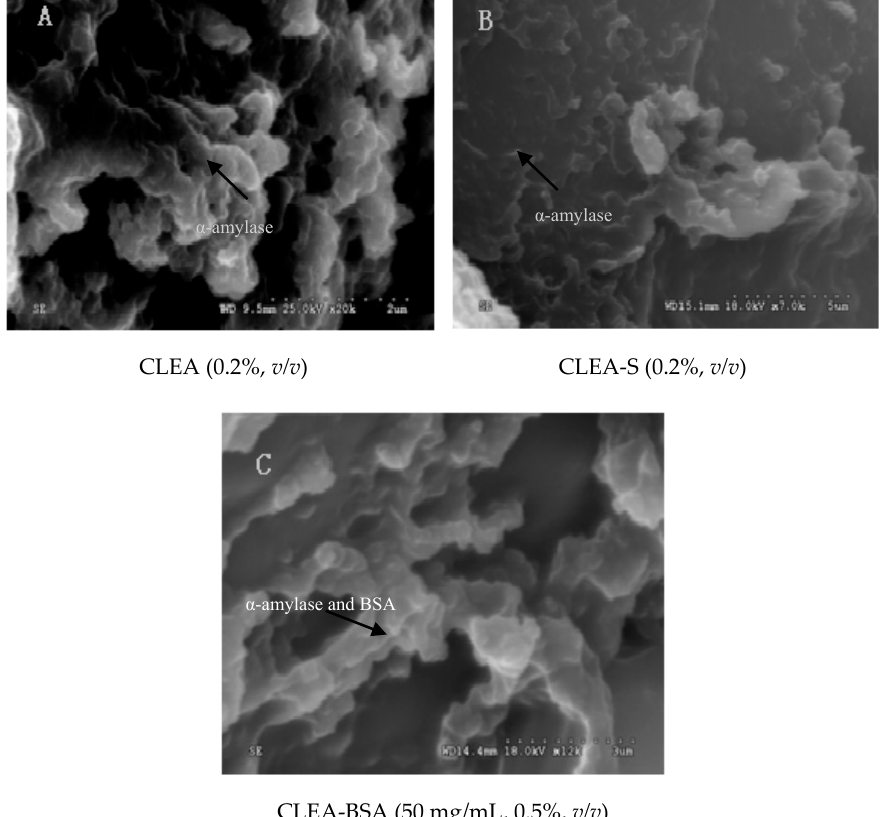
Figure 6. Scanning electron micrographs of ( A ) α -amylase CLEA absence of starch with 0.2% ( v / v ) glutaraldehyde concentration and magnified 20,000 × ; ( B ) CLEA with 2% starch solution and 0.2% ( v / v ) glutaraldehyde concentration, magnified 7000 × ; ( C ) CLEA with 50 mg/mL BSA, and 0.5% ( v / v ) glutaraldehyde, magnified 12,000 ×.